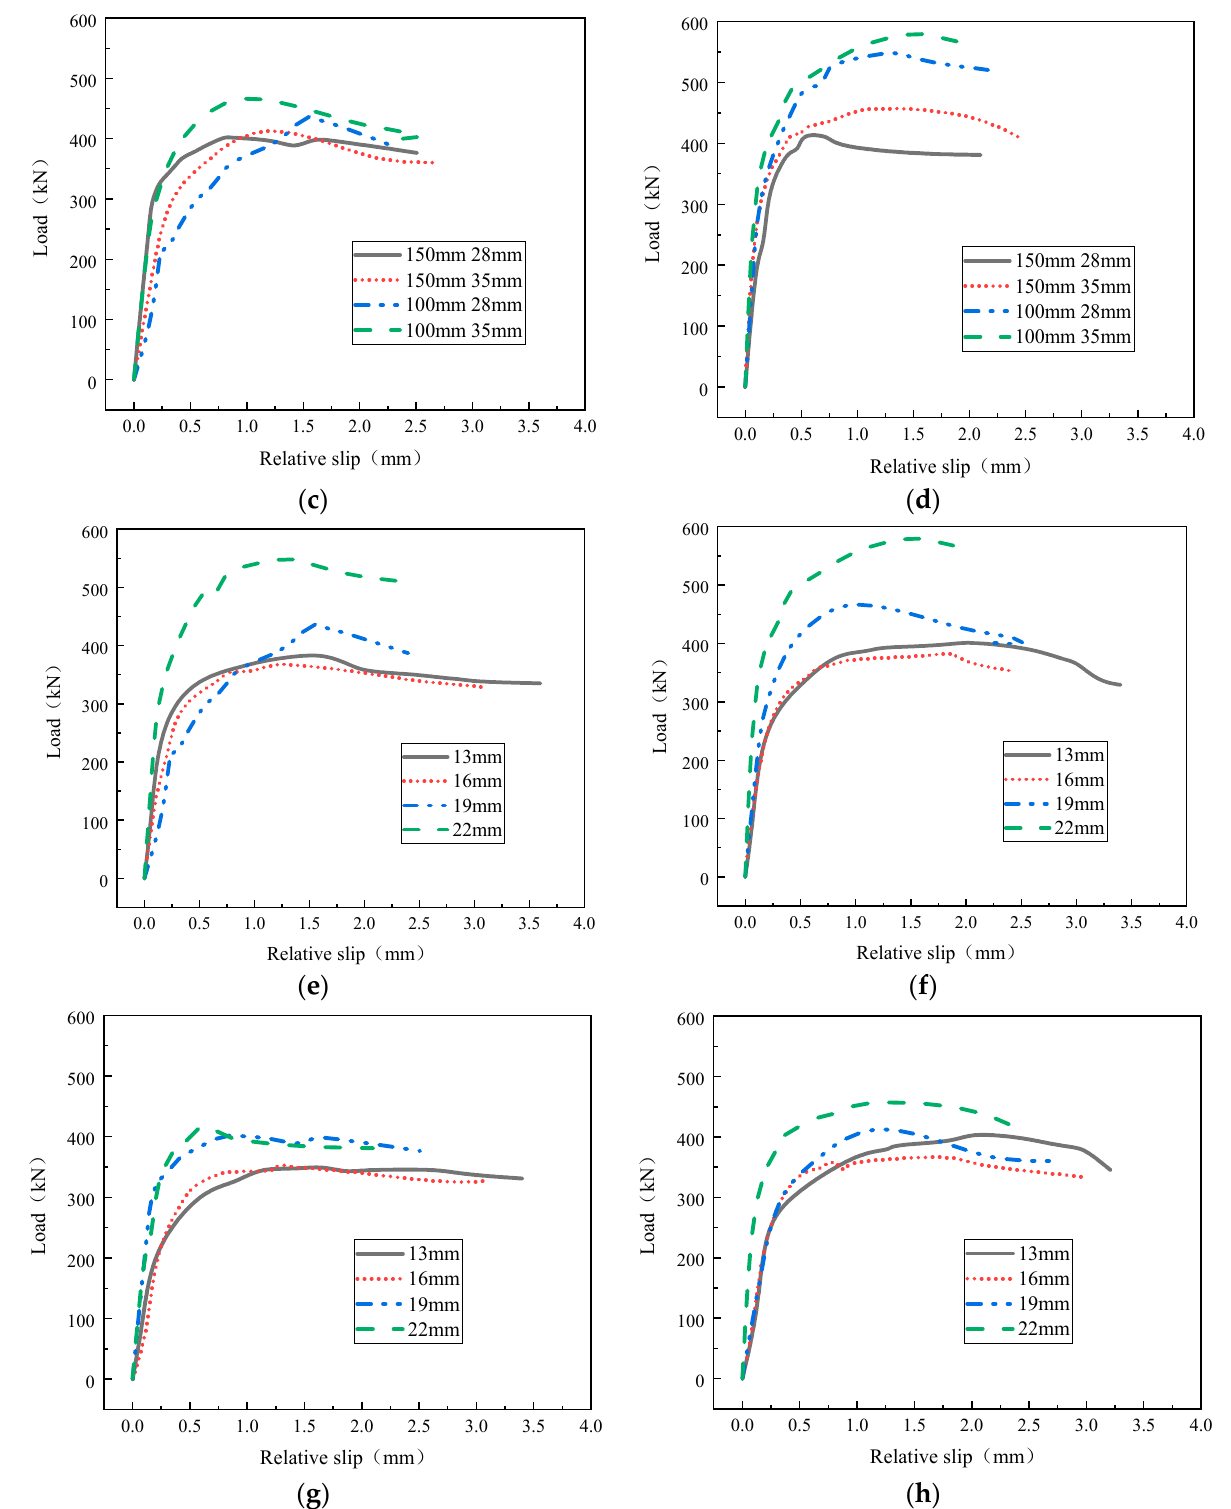
Figure 6. Load-relative slip curve of specimen: ( a ) 13 mm diameter peg; ( b ) 16 mm diameter peg; ( c ) 19 mm diameter peg; ( d ) 22 mm diameter peg; ( e ) 100 mm spacing, 28 mm length studs; ( f ) 100 mm spacing, 35 mm length studs; ( g ) 150 mm spacing, 28 mm length studs; ( h ) 150 mm spacing, 35 mm length studs.